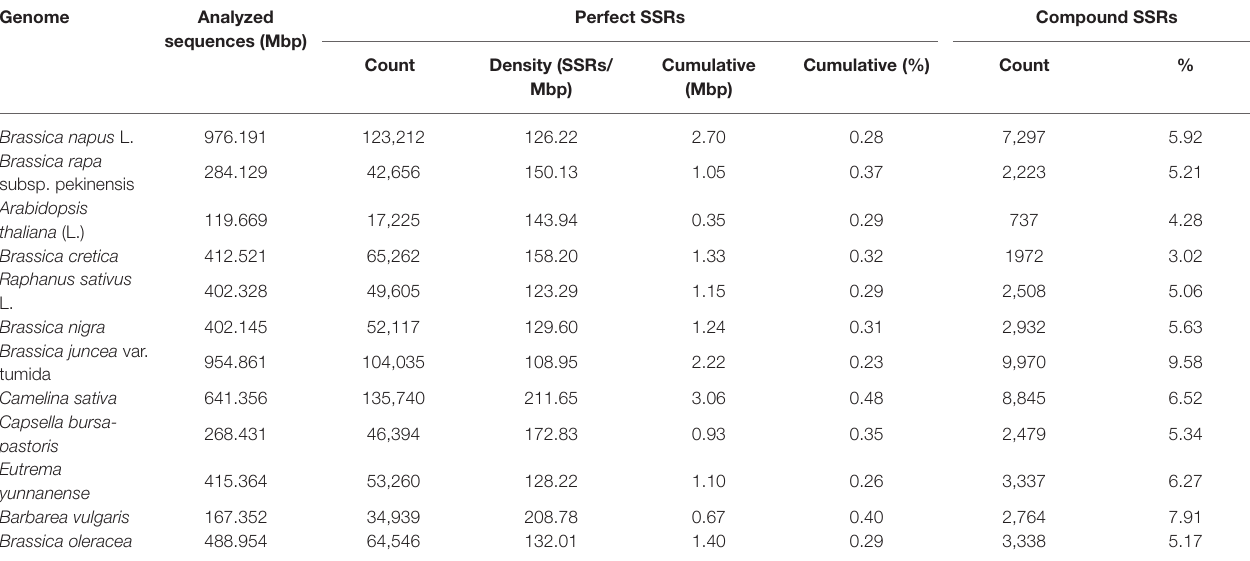
TABLE 1 | A comparative survey of perfect Simple sequence repeats (SSRs) across 12 analyzed genome sequences. Genome Analyzed sequences